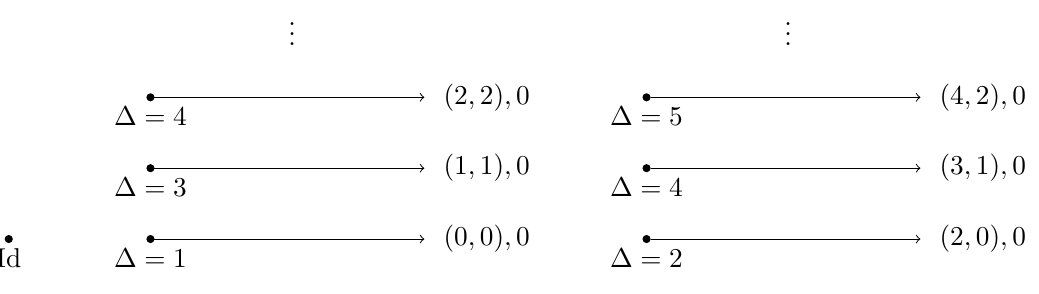
Figure 1 . Naive topology of (cid:6) in charge q = 0